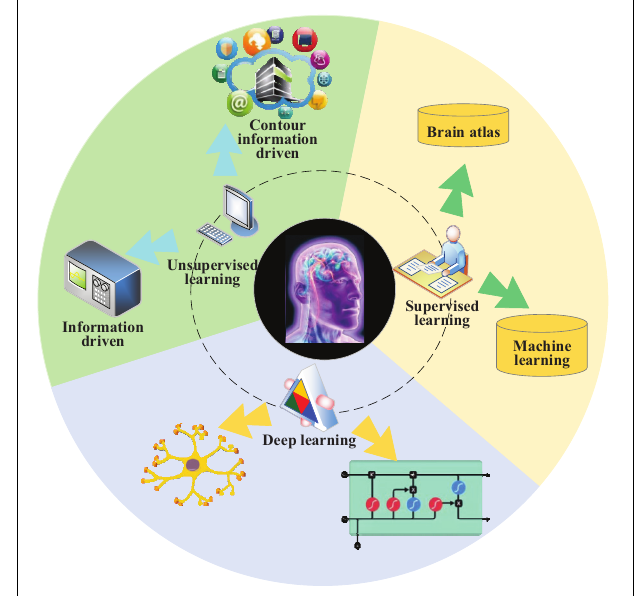
FIGURE 1 | Schematic diagram of brain image segmentation fusion